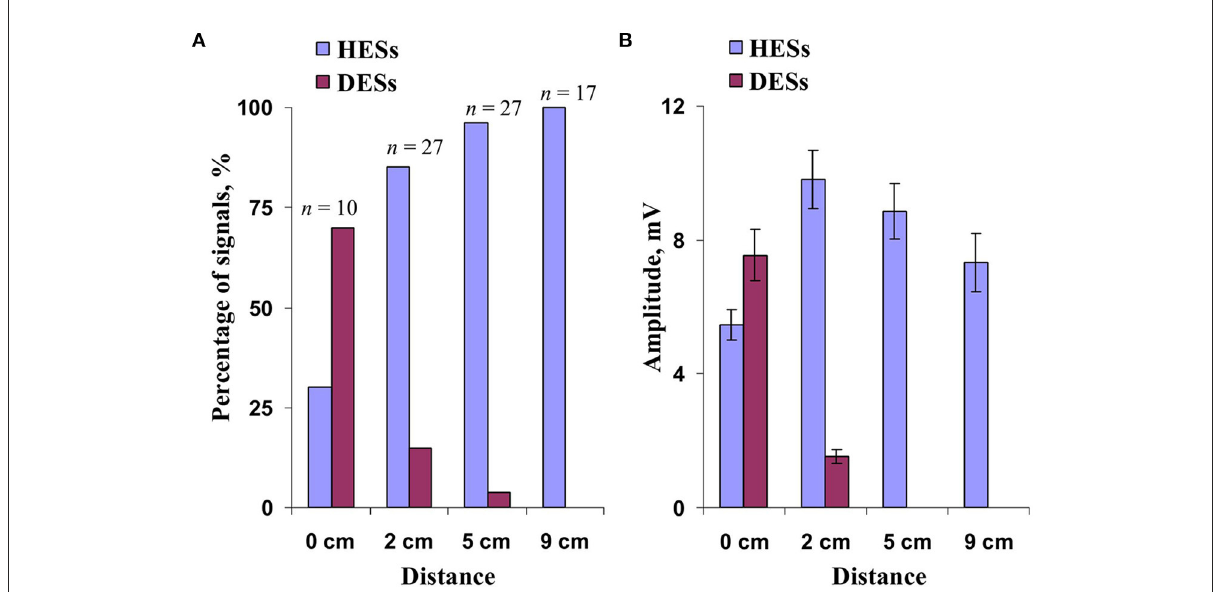
FIGURE3 Dependences of percentages of hyperpolarization electrical signals (HESs) and depolarization electrical signals (DESs) (A) and amplitudes of these signals (B) on distance from the zone of the local action of illumination and heating. Total dataset of electrical records (see Figure 2) was used for this analysis; n shows total quantity of repetitions for each distance. Average amplitude of DES at the 5cm distance was not calculated because only one DES was observed. Vertical bars represent standard errors.